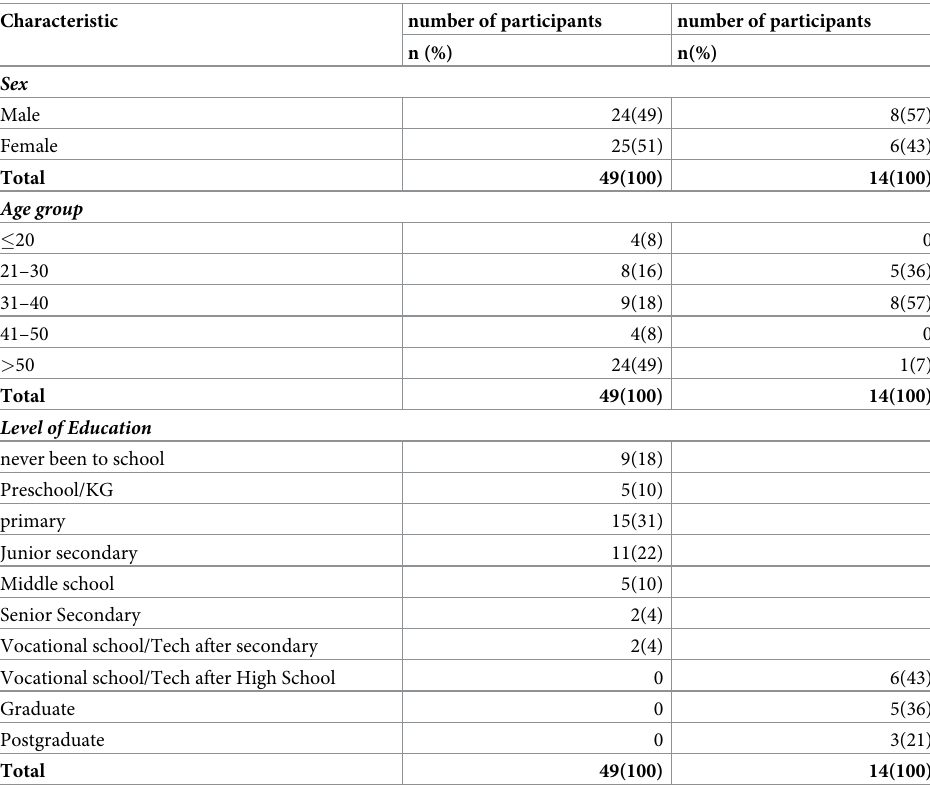
Table 1. Distribution of study participants during focus group discussion and in-depth